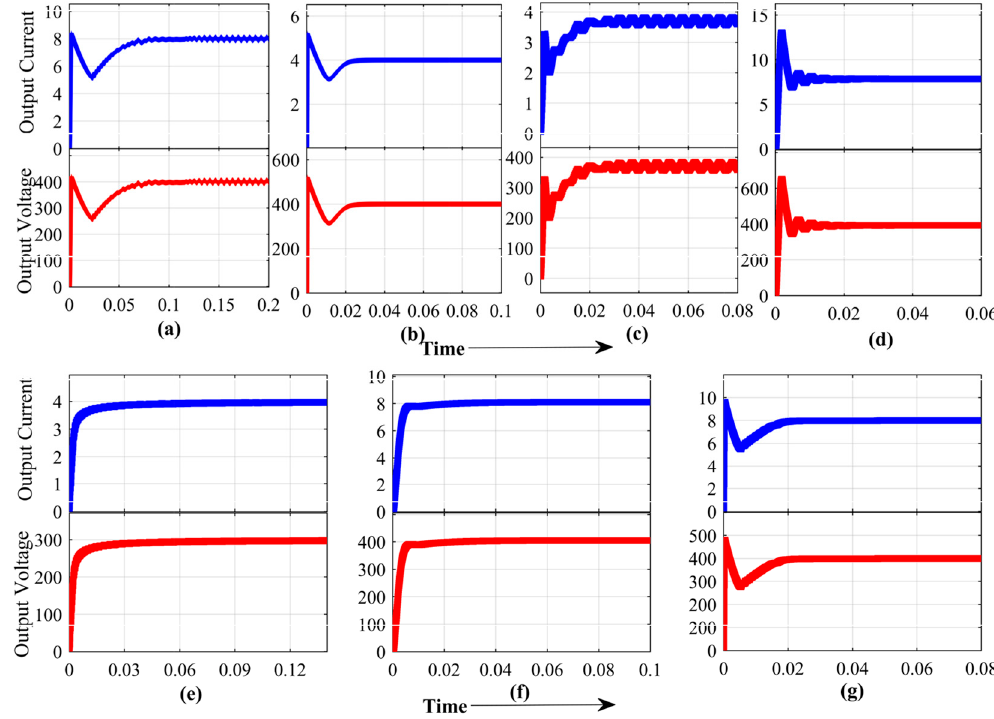
Figure 36. Output current-voltage waveforms of DC–DC rectifiers: ( a ) conventional BC; ( b ) IBC; ( c ) BCRC; ( d ) FBC; ( e ) ZVSC; ( f ) MPC, and ( g ) MDIBC.